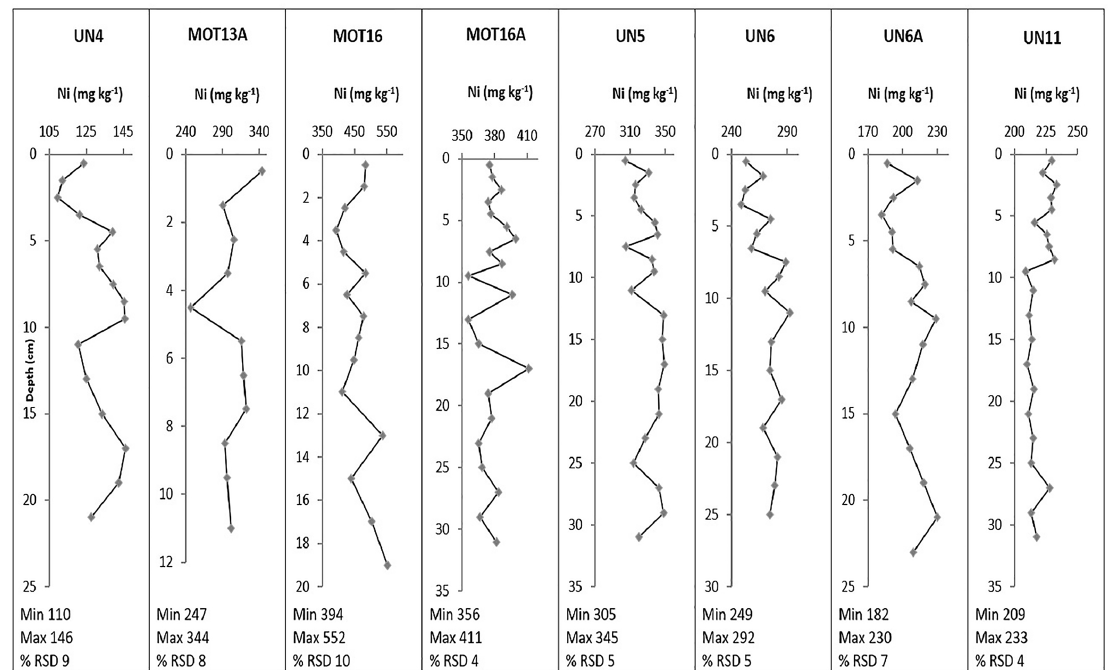
Figure A4. Vertical distributions of Ni in (in mgkg − 1 ) in sediment cores. The concentrations in the coarse cores MOT13A, MOT16 and UN4 refer to the total sediment fraction ( <